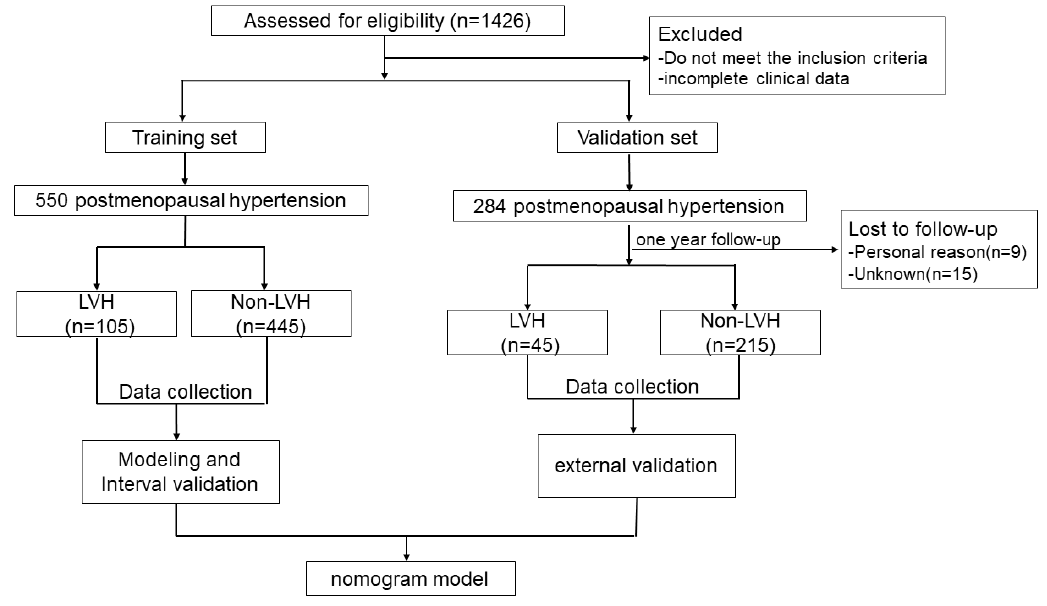
Figure 1. Research flow diagram; LVH: left ventricular hypertrophy. Table 1. Baseline clinical characteristics of postmenopausal women with hypertension in the train- ing and validation sets.